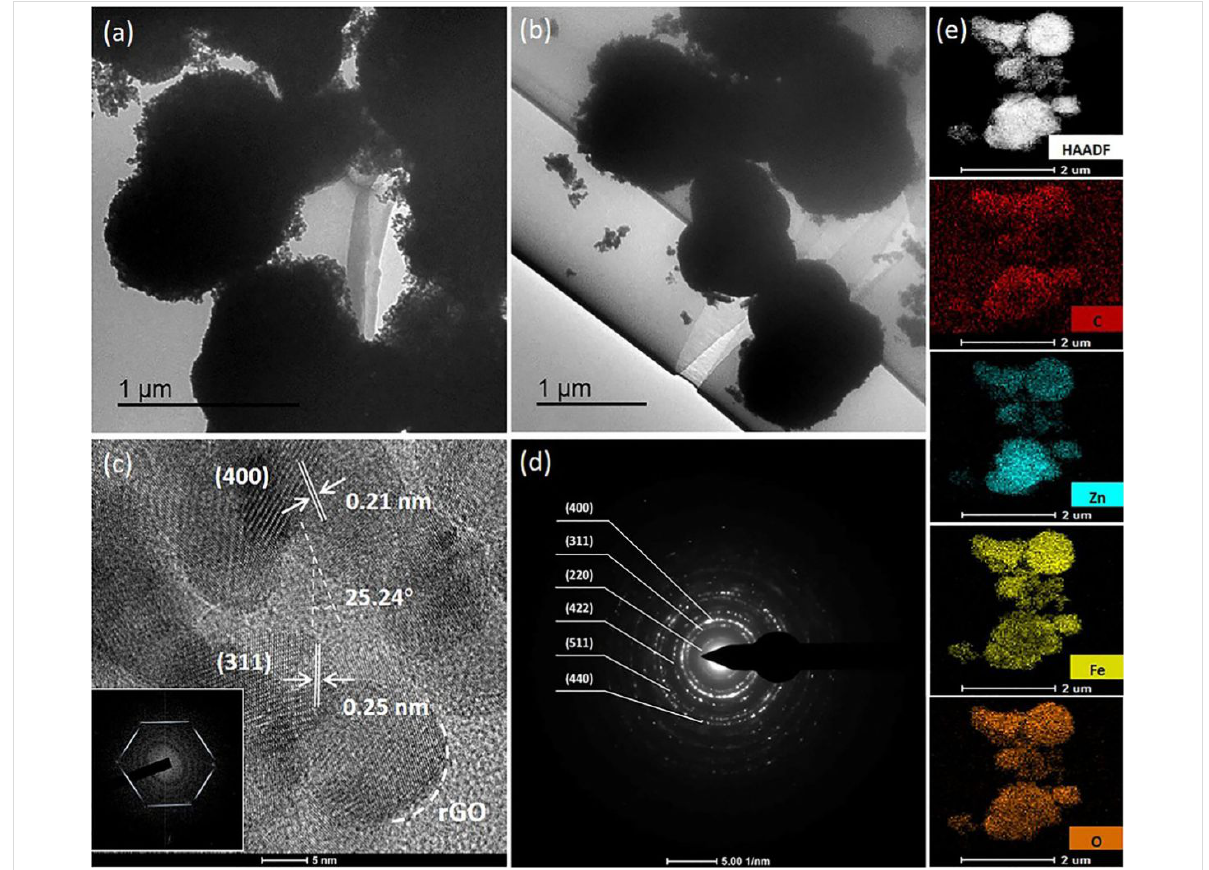
Figure 6: TEM images of (a) the 0.5 wt % ZnFe 2 O 4 /rGO spheres and (b) the 1 wt % ZnFe 2 O 4 /rGO spheres. (c) HRTEM image of the 0.5 wt % ZnFe 2 O 4 /rGO sample, the corresponding FFT image is shown in the inset. (d) SAED pattern of the 0.5 wt % ZnFe 2 O 4 /rGO sample and (e) HAADF- STEM image of the 0.5 wt % ZnFe 2 O 4 /rGO spheres and e) EDX elemental mapping images of C (red), Zn (blue), Fe (yellow) and O (orange).